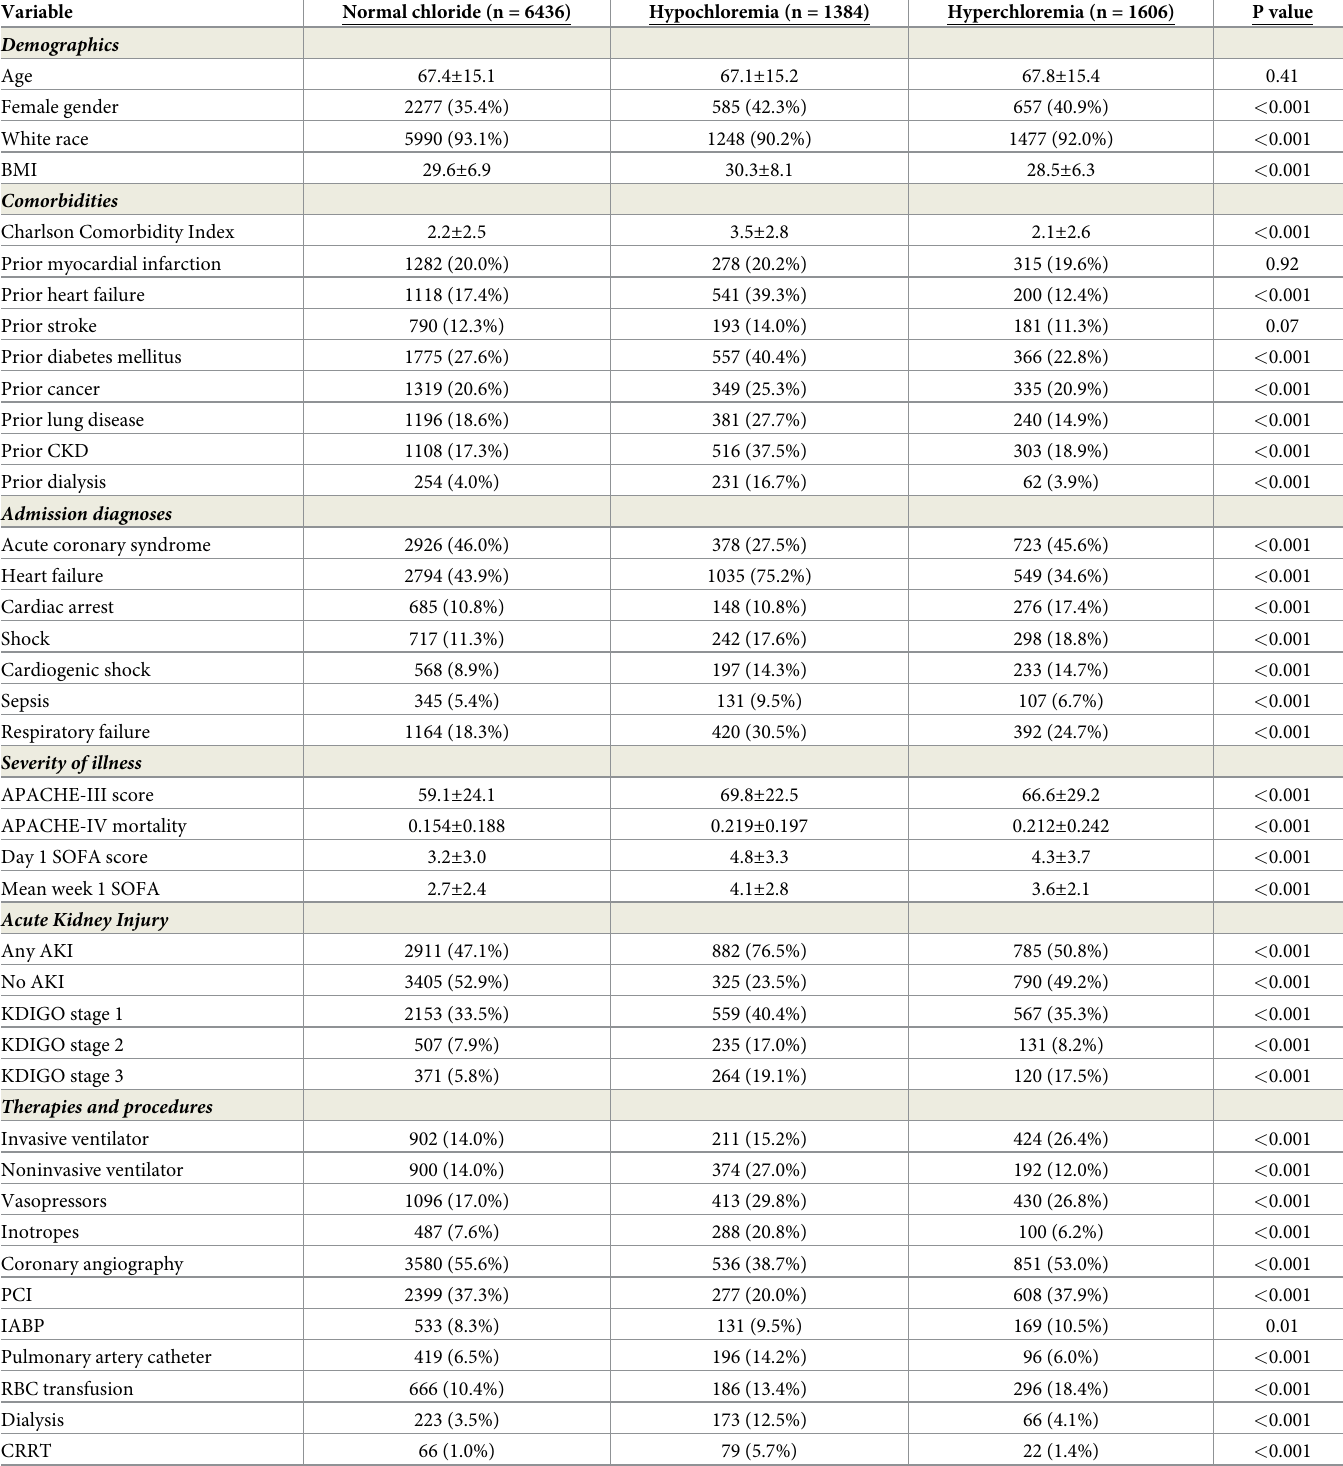
Table 1. Baseline characteristics of patients with normal chloride (admission chloride 98–107 mEq/L), hypochloremia (admission chloride < 98 mEq/L) and hyper- chloremia (admission chloride � 108 mEq/L). Data displayed as number (%) for categorical variables and mean ± standard deviation for continuous variables. Groups were compared using ANOVA for continuous variables and chi-square tests for categorical